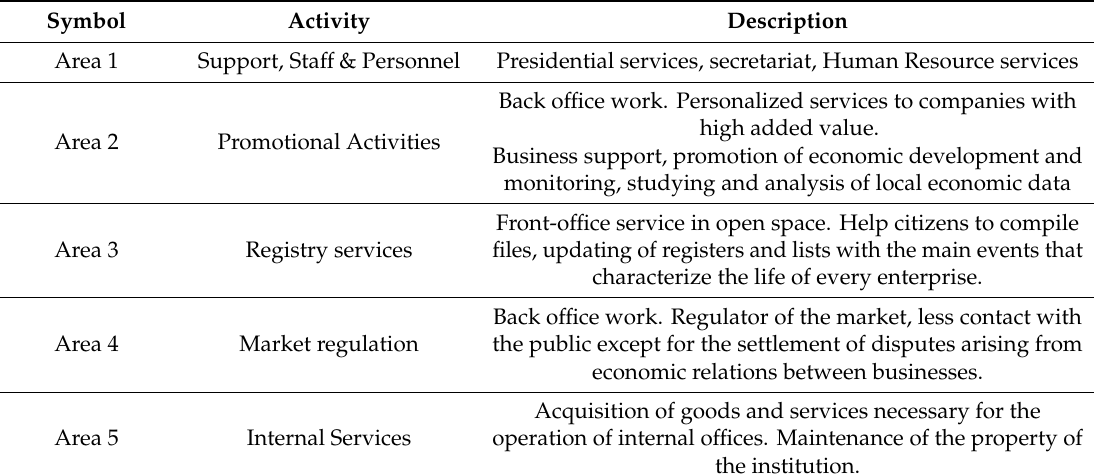
Table 2. Area 1- Area 5